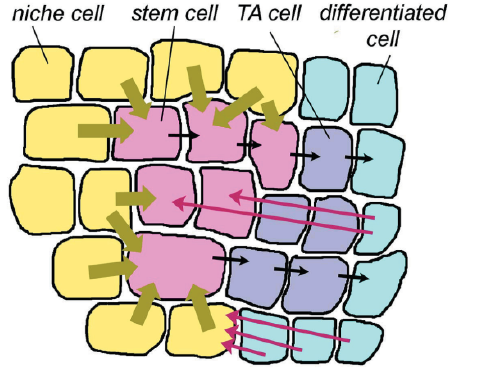
Figure 2: Different types of cell division: symmetric and symmetric in which short and long range signaling process are shown as depicted in